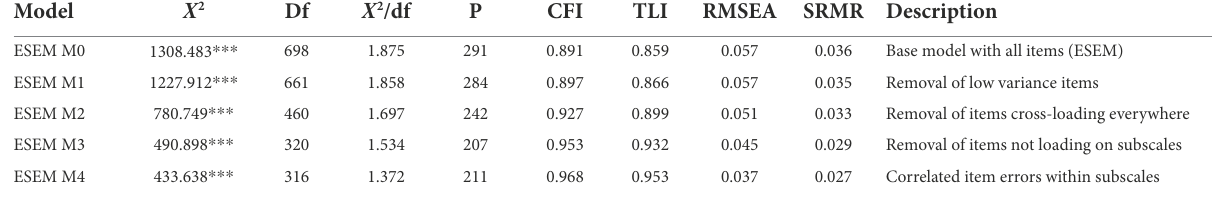
TABLE 1 Model fit, Study